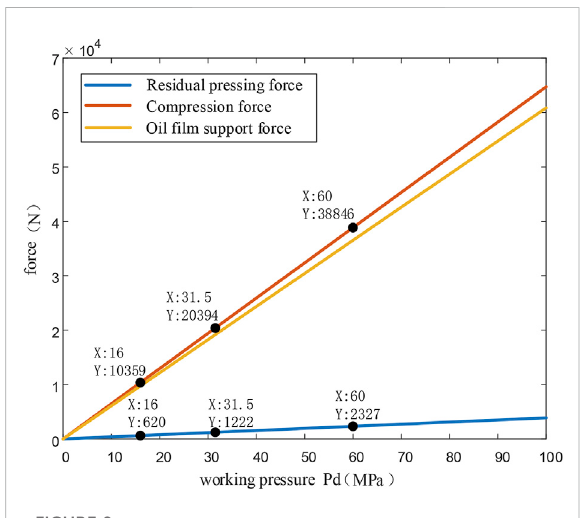
FIGURE 9 Relationship between residual pressing force, compression force, oil fi lm support force, and working